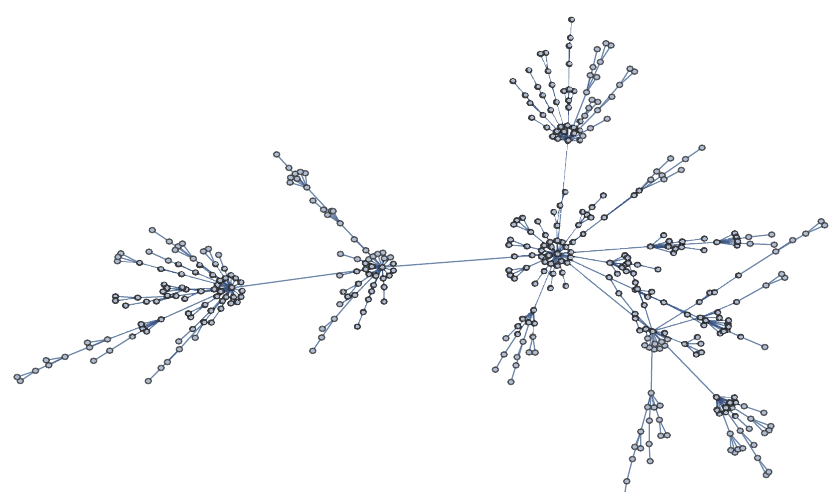
Figure 8: An example of a BA network with 400 nodes and 𝛽 = 1 , to which (28) has been applied for comparison to the corresponding mean-field